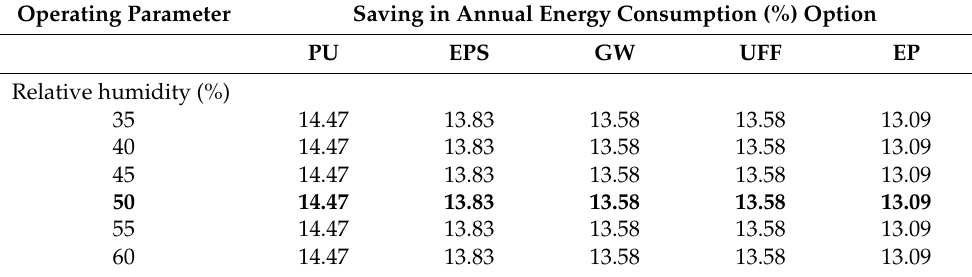
Table 5. Results of sensitivity analysis.